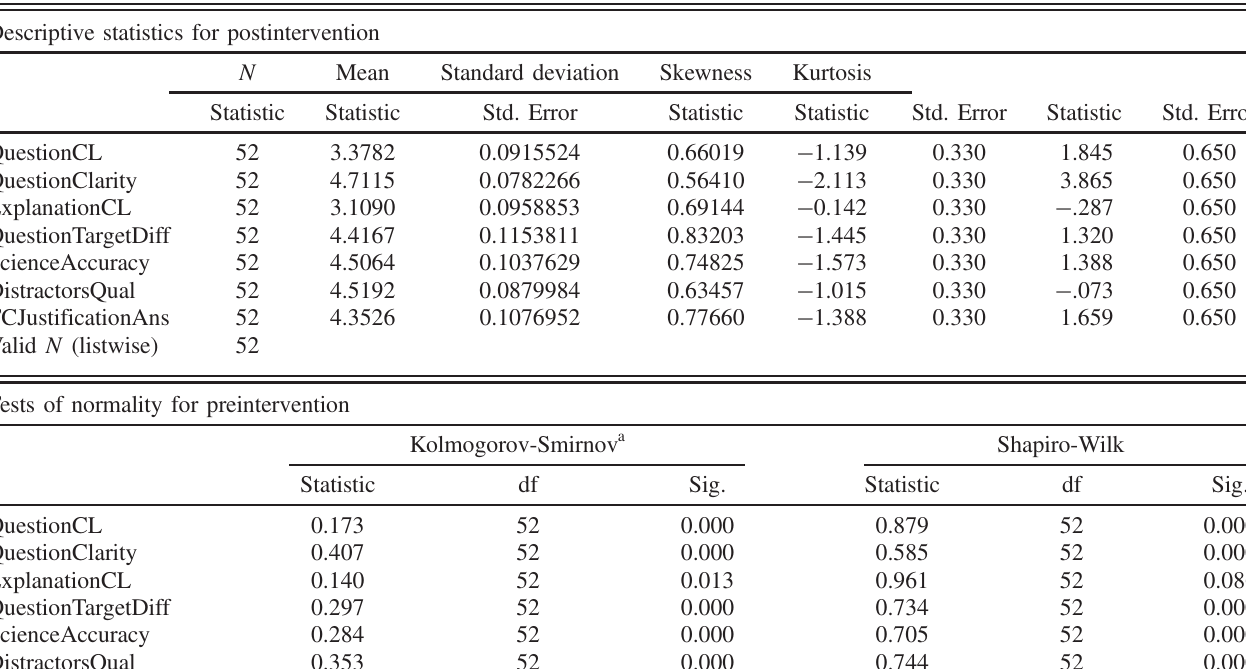
TABLE IX. Descriptive statistics and normality tests for